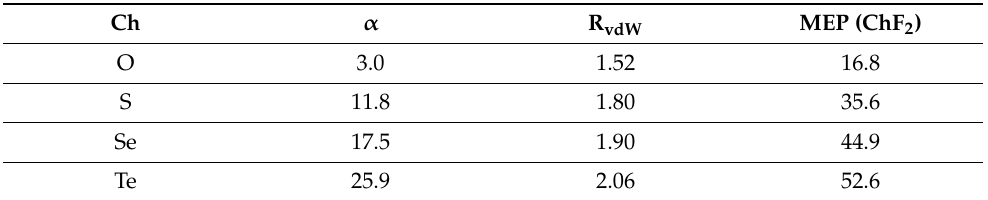
Table 3. Atomic polarizabilities ( α , a.u.) of chalcogen (Ch) elements, van der Waals radii (R vdW , Å) and σ -hole MEP values (MEP, kcal/mol) of their difluoride derivatives taken from ref. [63].